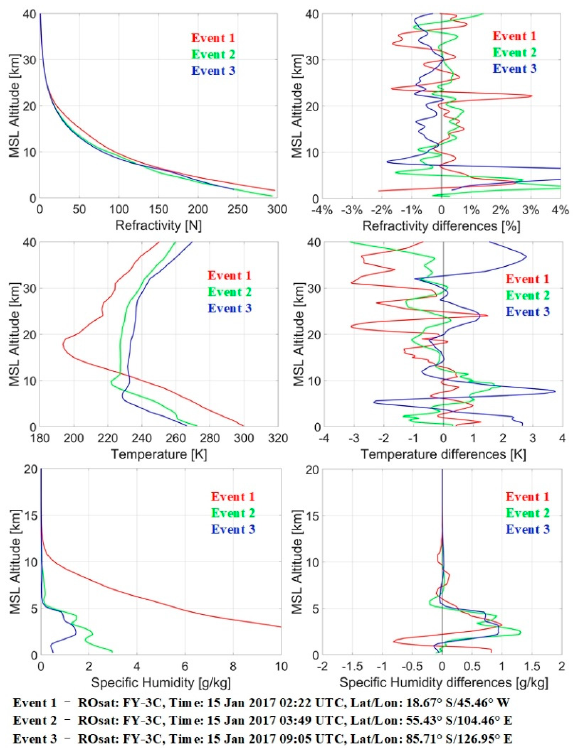
Figure 3. FY-3C refractivity, temperature, and specific humidity profiles (left panels) and their corresponding differences against collocated ERA - Interim profiles of three exemplary RO events as indicated in Figure 2.